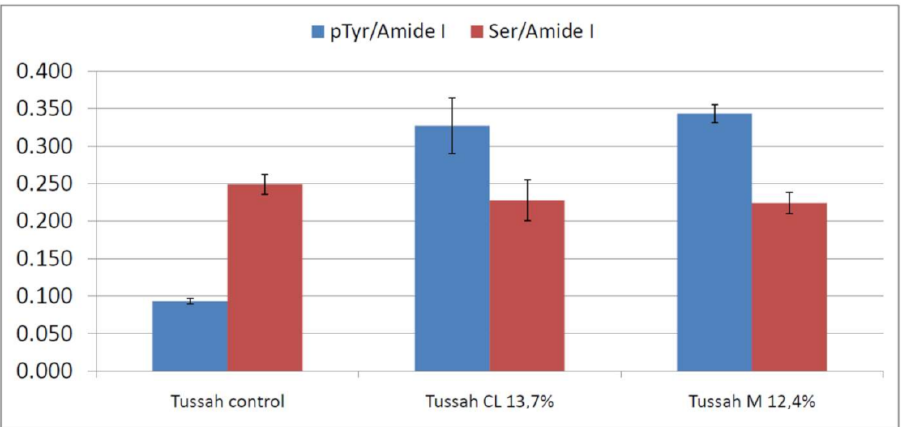
Figure 9. I pTyr /I Amide I and I Ser /I Amide I intensity ratios (average ± standard deviation, n = 4) obtained from the Raman spectra of Tussah silk fibroin fabrics under study. The IR spectra of Tussah silk fabrics grafted with phosmers are shown in Figure 10. Band wavenumbers and assignments are reported in Table S4, Supplementary Material.